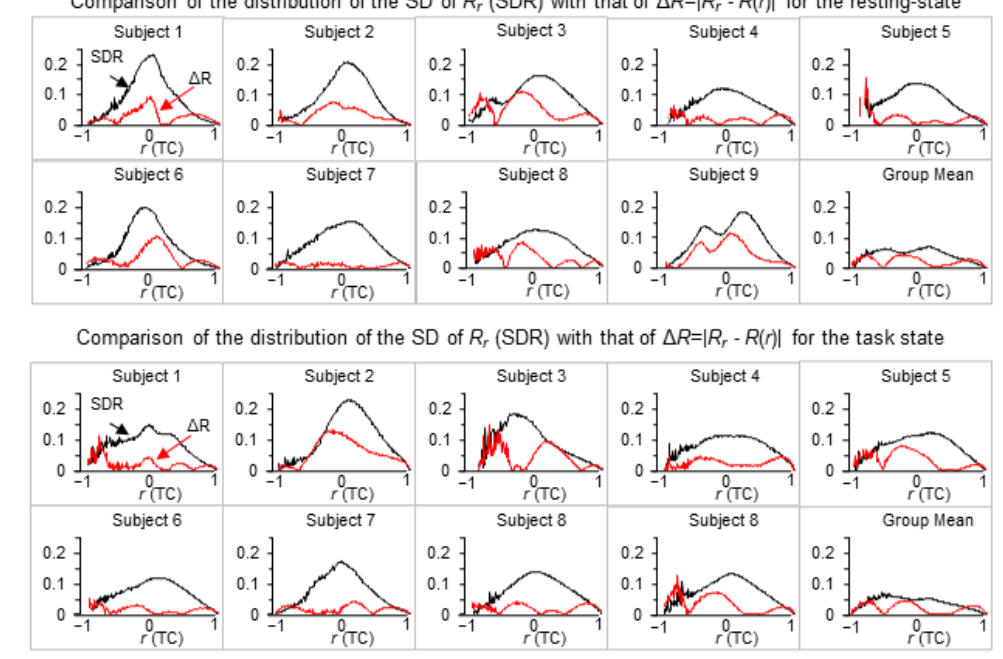
brain state of each subject (columns 1 – 3). For a given r value, the magnitude of each distribution represented the density that was computed as the percentage (%) of the total number of paired FAUPAs having the same r value relative to the total number of all pairwise combinations of the FAUPAs for that state and that subject (Equation (4)). The density-weighted mean of each r distribution (Equation (5)) yielded a mean r that quantified that distribution to a certain degree: the larger the mean r , the stronger the mean co-activity among all the FAUPAs. Note that, for each subject, the